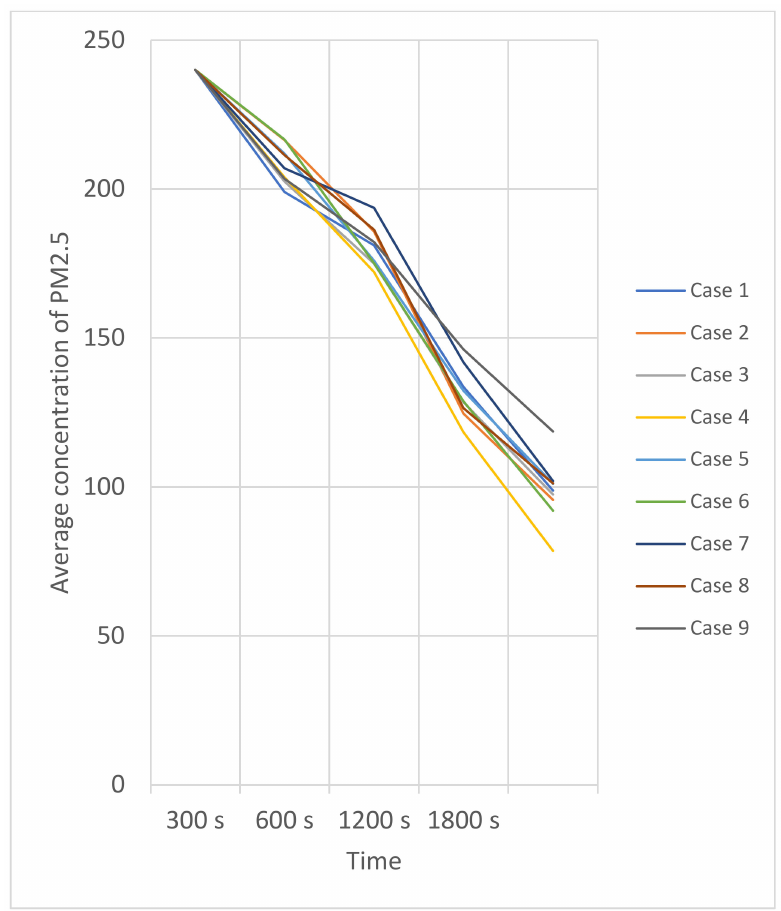
Figure 7. The average concentration of PM2.5 at different times.